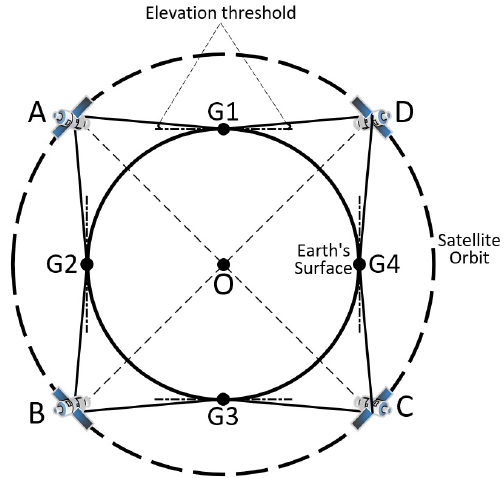
Figure 11. The critical state of two satellites observed by the same user. O is the center of the Earth, and G1, G2, G3, and G4 are the locations of users. A, B, C, and D are satellites with the same orbital altitudes, which are uniformly